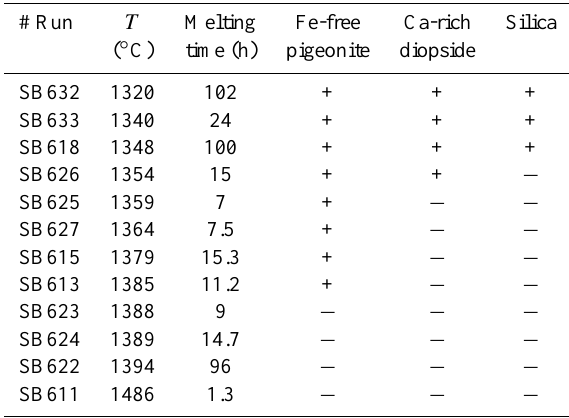
Table 1. Isothermal crystallization experiments with composition A. # Run T Melting Fe-free Ca-rich Silica